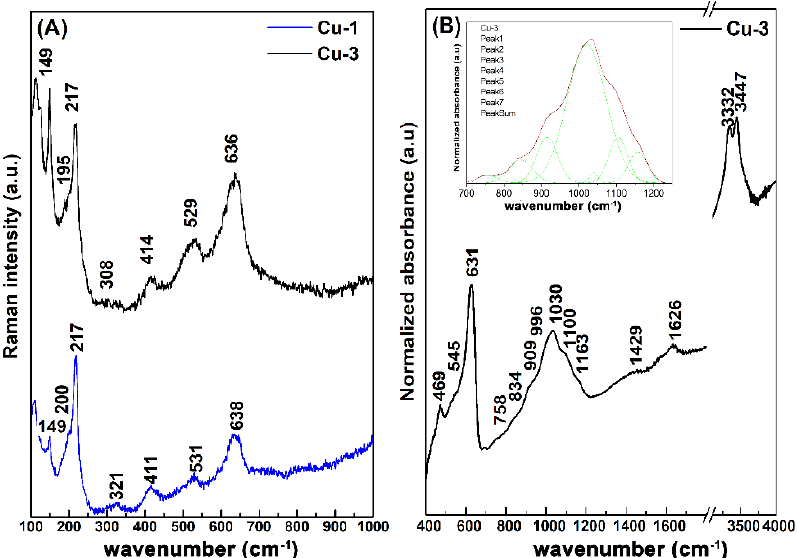
Figure 10. ( A ) Raman spectra of the copper samples at 1 and 3 years, recorded with a 532-nm laser line. ( B ) FTIR spectra of the corrosion product extracted from the sample at 3 years of exposure, recorded in KBr.